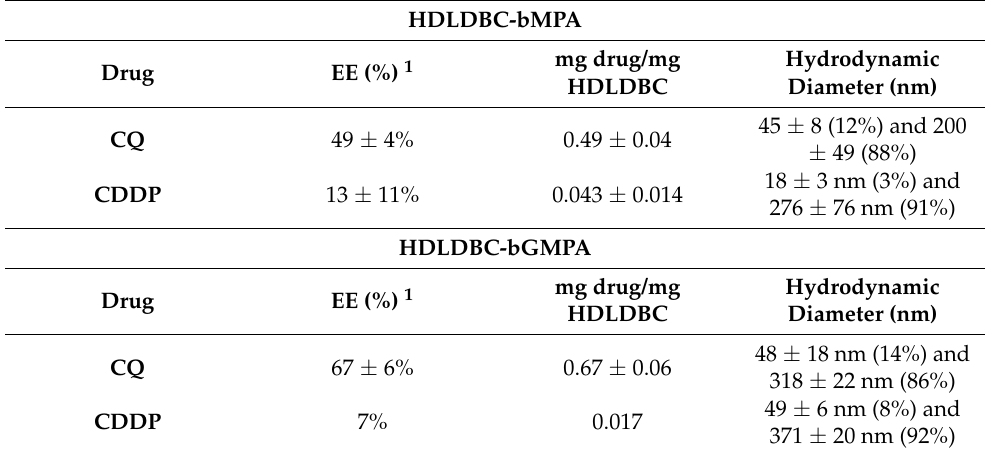
Table 2. Encapsulation efficiency of CQ and CDDP in HDLDBC-bMPA and HDLDBC-bGMPA nanocarriers. Hydrodynamic diameter of the aggregates with encapsulated drugs measured by DLS and given as intensity average.